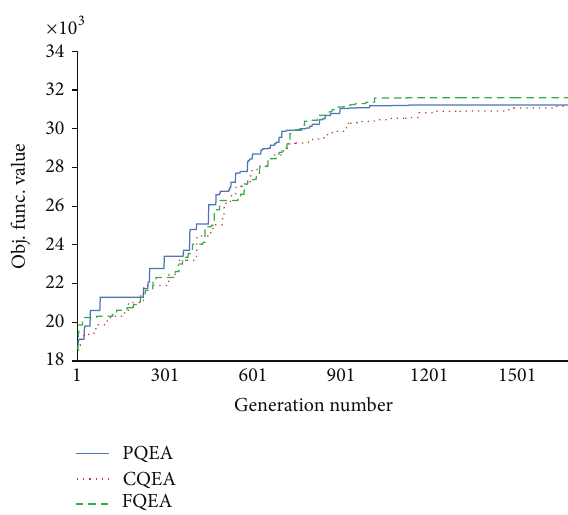
Figure 37: Convergence graph of PQEA, CQEA, and FQEA on 0-1 knapsack problem with circle data instances with number of items, 𝑀 , being 200 and capacity, 𝐶 , being 5% of total weight.